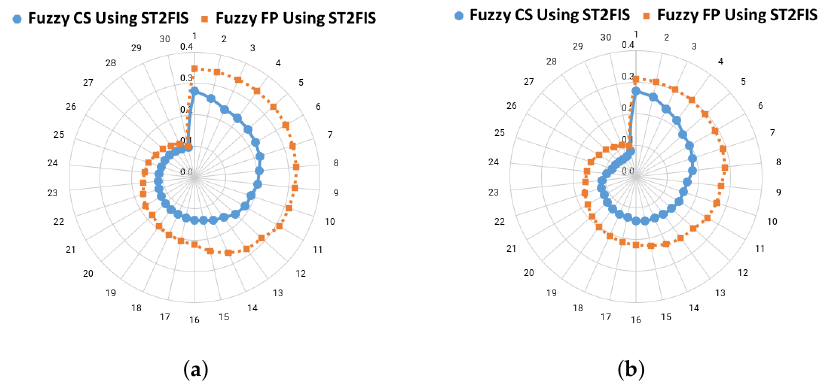
Figure 20. MSE error comparison for 30 simulations. ( a ) TTCFNLC with actuator fault and noise in the fuzzy controller. ( b ) TTCFNLC with leak fault and noise in the fuzzy